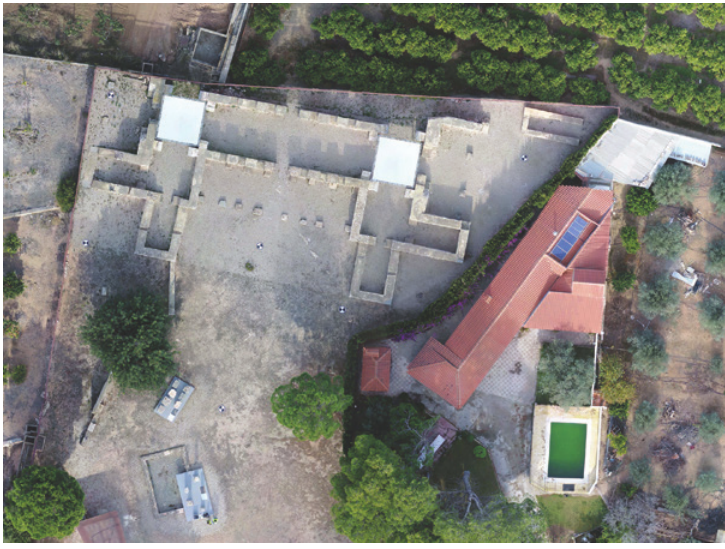
Figure 2 Aerial orthophoto of the late-seventh-century palace of Pla de Nadal, Valencia. (Image credit: ULP.PILAEMA